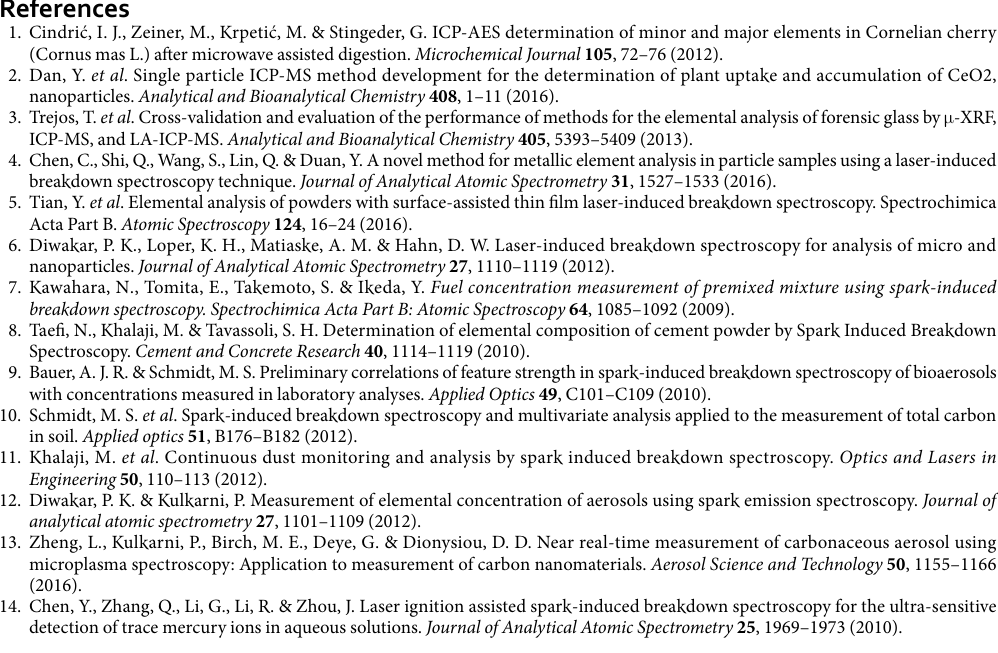
Particle flow was generated using a piezoelectric type vibrational feeder (PEF-90A, Sanki, Japan) with a tapered tube, which is used to enrich the particles and reduce the flow fluctuation. Then the particles passed through the spark gap with a mass flow maintained at 1.2 g/min throughout the experiment. In the spark gap, air plasma was generated between two 1 mm coaxial electrodes with conic shaped tip by a high voltage pulse from the voltage power supply (4.5 kV, DC), the distance between electrodes was 1 mm for stable discharges. As the particles were ablated and vaporized by the air plasma, characteristic spectra from the samples were emitted and then collected and transmitted to a spectrometer (AvaSpec-2048, Avantes, Holland) by an optical fiber for analysis. The dual channel spectrometer covers a wavelength range from 235 to 400 nm and 575 to 790 nm, with a spectral resolution of 0.1 nm. Moreover, the spectrometer was synchronized with the high voltage power supply by a delay generator (DG535, Stanford Research Systems, America) to adjust the pulse frequency and delay time. Mo, Pt, Cu and W of 99.9% purity were selected as the electrode materials in the experiment. To avoid the interference of matrix effect from complex samples composition, quartz sands were selected as experiment sam- ples. Five diameters samples were prepared: 180, 150, 106, 75, 45 μ m, which are among the approximately distri- bution of particle sizes in practice.